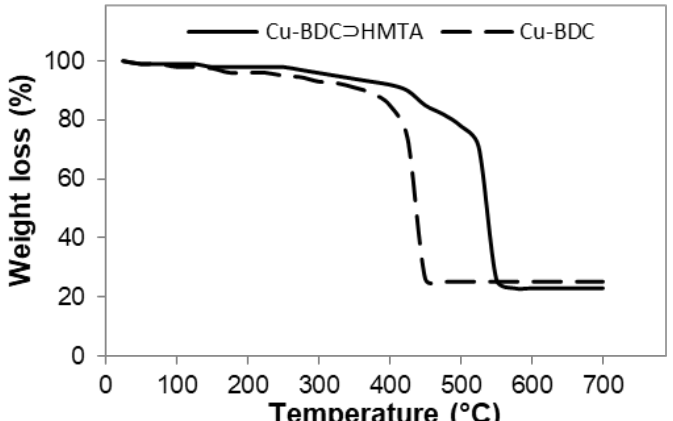
Figure 4. TGA of Cu-BDC MOF (dashed line) and Cu-BDC ⊃ HMTA (solid line).